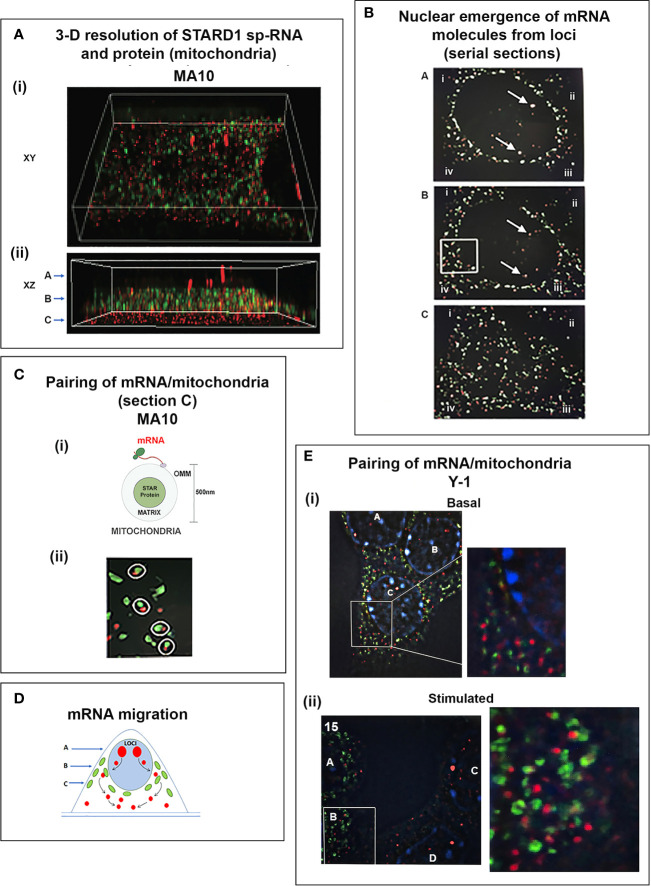
sm-FISH identification of single cell location of STARD1 mRNA in relation to gene loci and mitochondria. Identification of 1:1 mRNA-mitochondria association. (A) MA10 cell 3D assembly of STARD1 sp-RNA/mRNA and protein/mitochondria 180 min after Br-cAMP stimulation. (i). XY shows top view; (ii). XZ shows side view. (A–C) arrows indicate levels used for three optical slices in B. Red: sp-RNA at loci (intense) and in cytosol as mRNA; Green: STARD1 protein in mitochondrial matrix. Studies with Mitotracker and STARD1 protein show near total overlap. (B) In slices A and B, mitochondria with high STARD1 protein (green/white) mark the nuclear envelope, which they encircle. Same two nuclei (red/white; arrows) are detected in each section (slice A>slice B). Single mRNA particles (red) move from loci to nuclear pores. Outside the nucleus, many mRNA pair with single mitochondria marked by STARD1 protein (boxed area enlarged in section C). Slice C is below the nucleus. mRNA less frequently paired with mitochondria (see section A). (C) (i). Diagram shows spacing for mRNA attached to ribosome, separated from STARD1 protein in the mitochondrion matrix. (iii). Pairing of mRNA and mitochondria (box slice B). (D) Diagram shows movement of mRNA particles from loci to lower cytoplasm zone. (E) Y-1 cells imaged for STARD1 sp-RNA/mRNA and protein/mitochondria. (i). 3 basal cells (A, B, C) marked by DAP1 nuclei each show STARD1 mRNA (red) and protein (green). (Box Enlarged) Cell C; 15-20 mRNA particles and mitochondria/STARD1 with six examples of mRNA/mitochondrion pairs. (ii). 15-min Br-cAMP stimulation (four cells). Similar pairing of mRNA and mitochondria. Some mitochondria cluster without mRNA. Portions of this figure were previously published (146, 150).